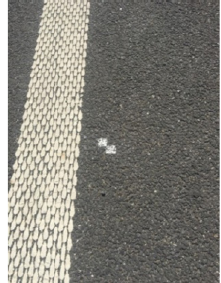
Figure 10. Ground control